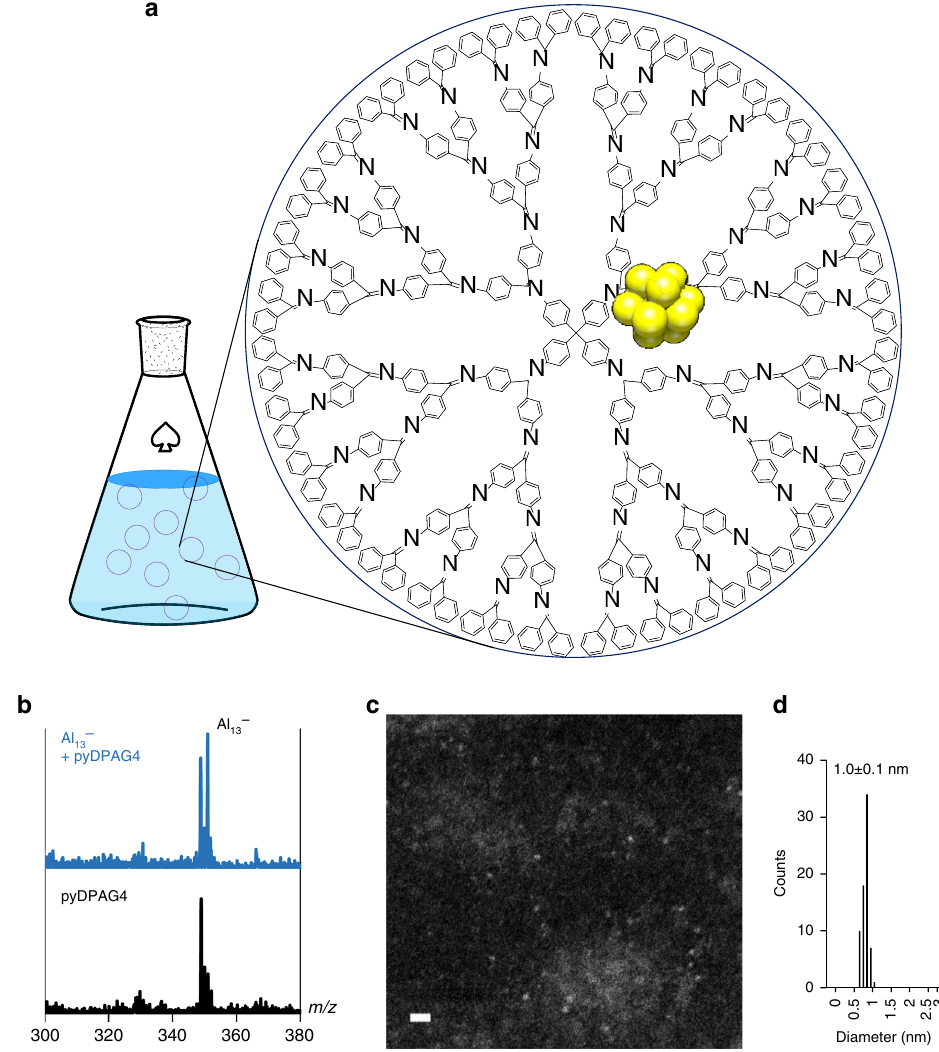
Fig. 1 Fabrication of Al 13 − using the dendrimer template. a Illustration of dendritic poly-phenylazomethines including an aluminum cluster in the solution state. b Negative-mode matrix-assisted laser desorption/ionization mass spectra of Al 13 − and blank. 1,8,9-Trihydroxyanthracene was used as the matrix. c A high-angle annular dark- fi eld scanning transmission electron microscopy image of Al 13 − on a TEM grid covered with a thin carbon fi lm (scale bar: 5 nm). d Histogram of the observed particle sizes in the STEM